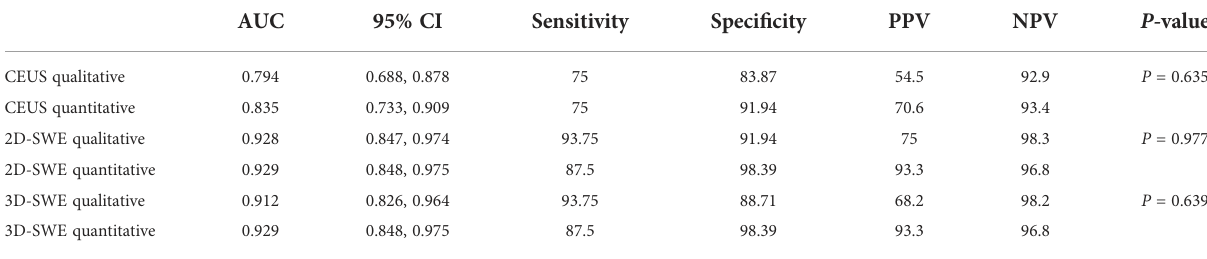
TABLE 3 The diagnostic performance of the quantitative and qualitative analyses of 2D-SWE, 3D-SWE, and CEUS in the training cohort.